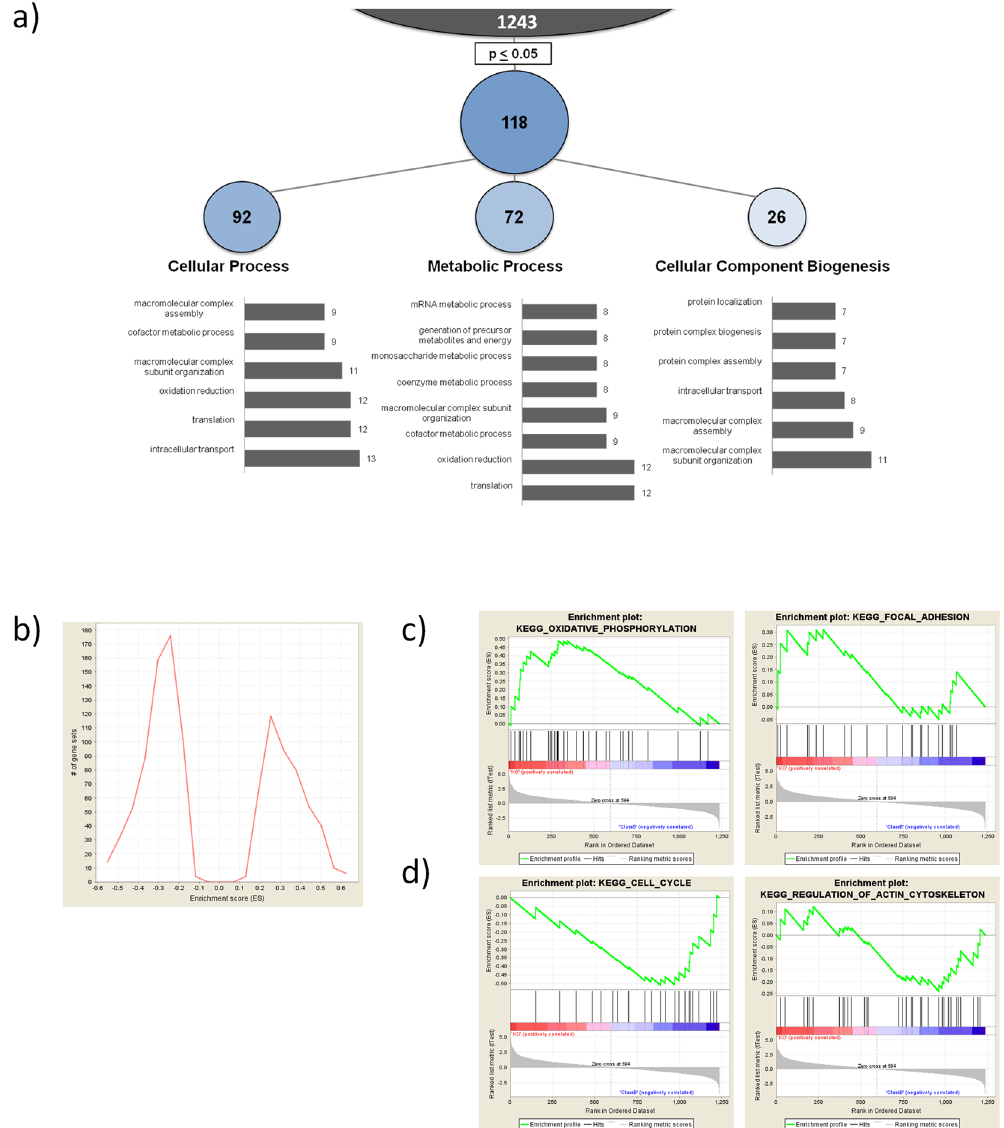
Figure 4. Bioinformatic analysis of the proteomic dataset. ( a ) Targets for DAVID 6.7 analysis with the GOterm BP database were chosen from the whole dataset for every protein with p ≤ 0.05 after student’s t-test KO vs Ctrl ( b ) Distribution of ES Scores in a GSEA of KO vs Ctrl with Gene Ontology (c5.all.v5.2) and KEGG (c2.cp.kegg. v5.2) reference database ( c ) GSEA Enrichment-Plot analysis of the whole dataset shows two exemplary KEGG pathways. Oxidative phosphorylation and focal adhesion showing overexpression while ( d ) cell cycle and regulation of actin cytoskeleton are being down